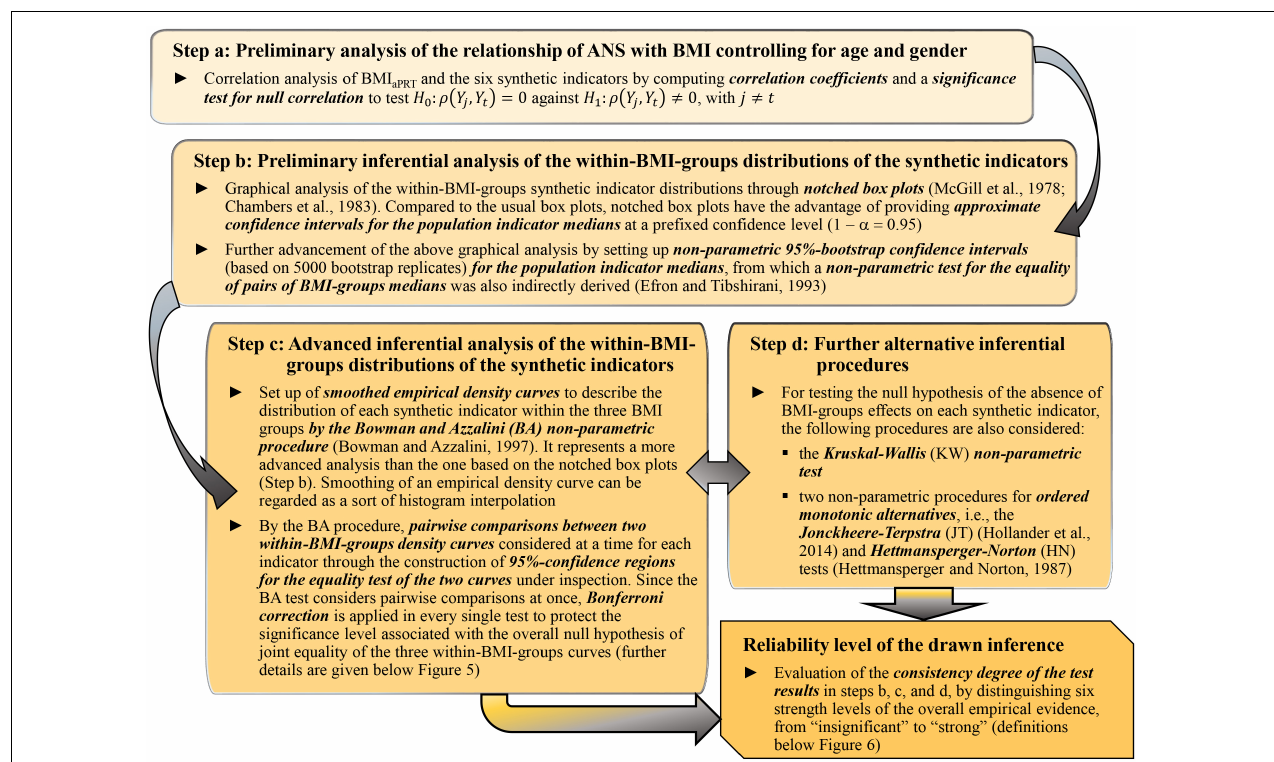
FIGURE 2 | Steps of data-driven statistical analyses performed to study the effects of the BMI categorization in NW, OW, and OB groups on the synthetic indicators.